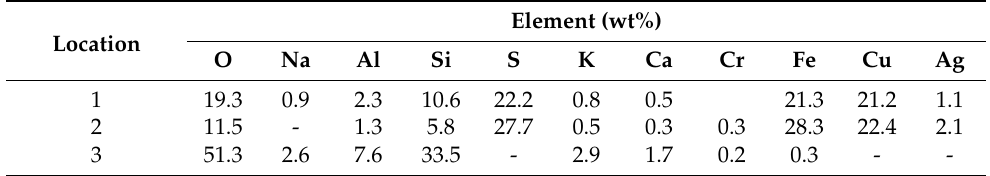
Figure 16. ( i ) Analysis of scaling/deposits in the eroded crater area and ( ii ) vertical microcracks were observed in the carbon steel substrate, at the coating interface, in the MO-HEA-S235JR sample. Table 5. Elemental XEDS analysis from locations in Figure 16i.